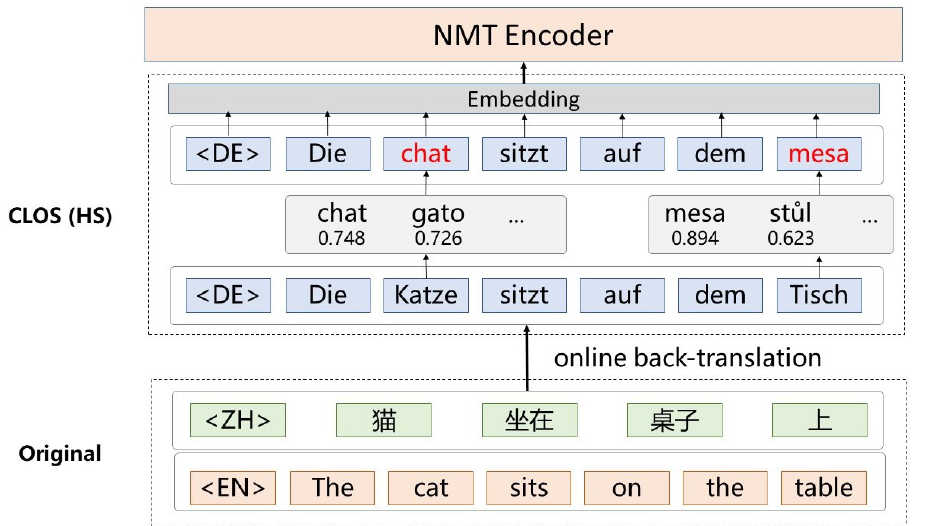
Figure 1. Cross-lingual online substitution by randomly replacing words with their synonyms from other languages. Hard substitution determines the synonyms by ranking the embedded similarities.